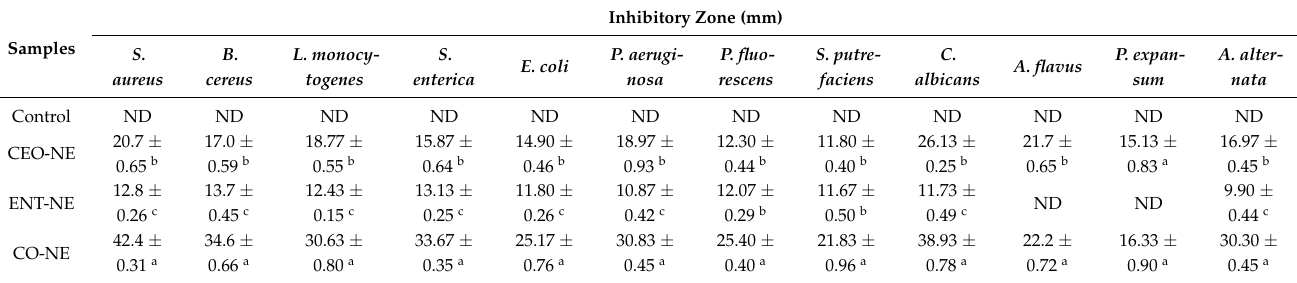
Table 3. The antimicrobial activity of nanoemulsions containing enterocin Gr17 alone (ENT-NE), cinnamaldehyde alone (CEO-NE), enterocin Gr17 and cinnamaldehyde (CO-NE) and no enterocin Gr17/cinnamaldehyde